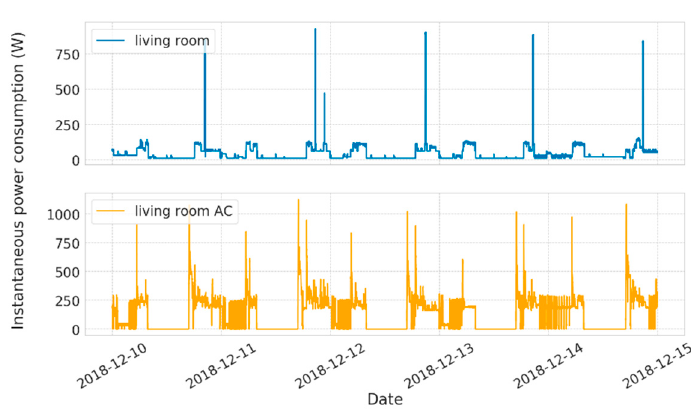
Figure 1. Power consumption of electric appliances in the living room (in blue) and the AC (in orange). The data is measured for each branch of the distribution board by an energy measuring unit.